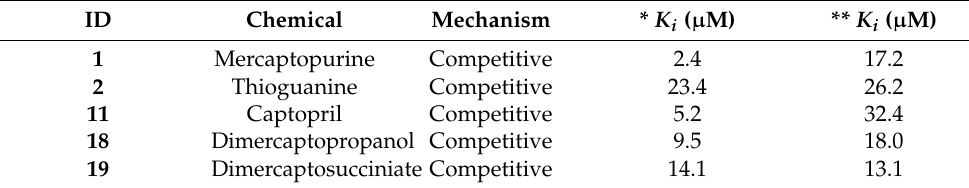
Table 2. Parameters of inhibitory kinetics for laccases.